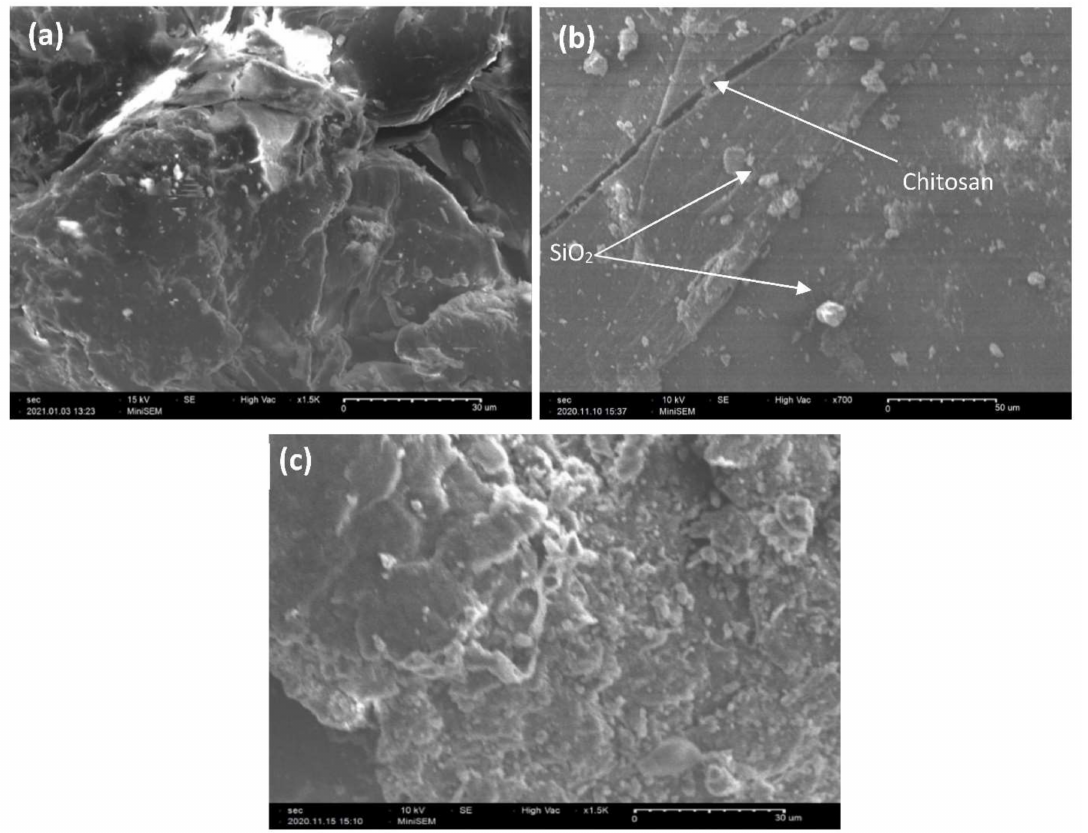
Figure 3. SEM images of Cs ( a ), Cs–Si ( b ), and Cs–Si–Hap ( c